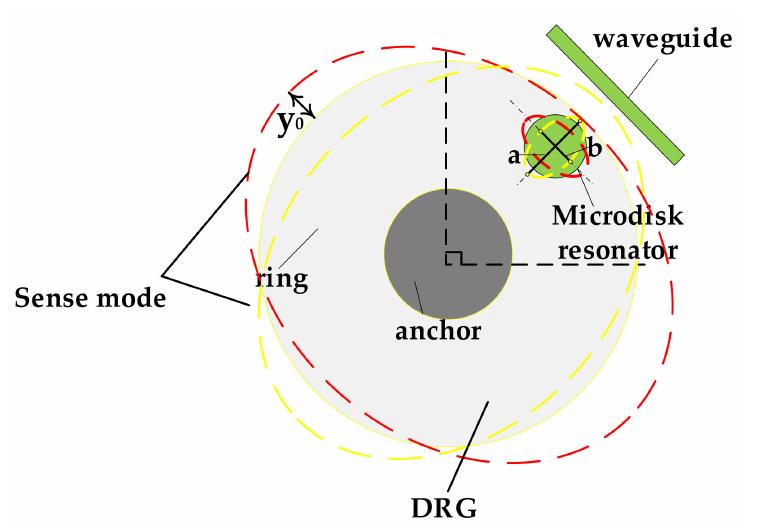
Figure 12. The diagram of the WGM resonator